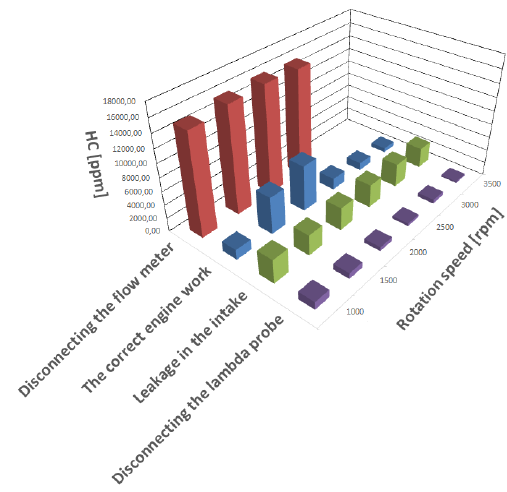
Fig. 10. The content of hydrocarbons in the exhaust gas of a BMW engine fueled with petrol working efficiently and for simulated damage